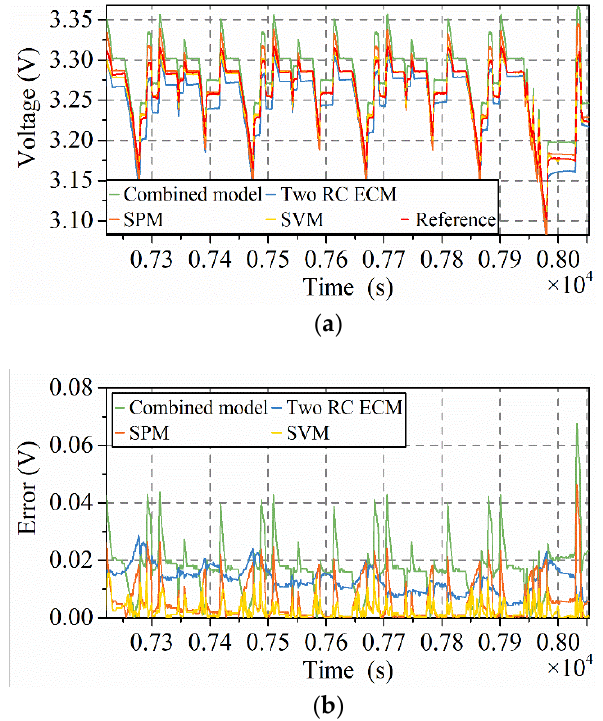
Figure 9. Zoom of the voltage prediction achieved by using the four models (from 7221s to 8054 s): ( a ) Voltage; ( b ) absolute error.